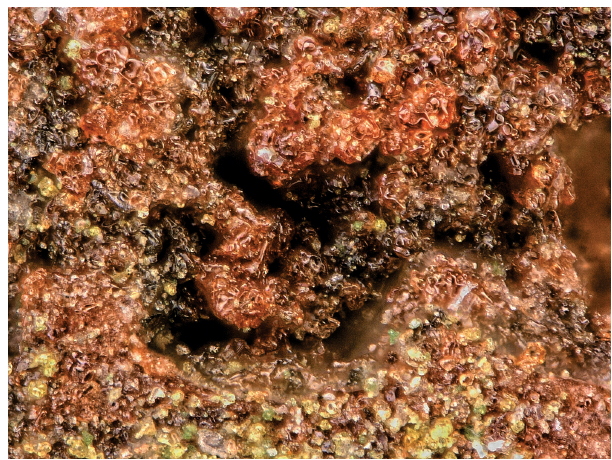
Figure 5. Raman spectra of johanngeorgenstadtite and niasite recorded using a 532nm